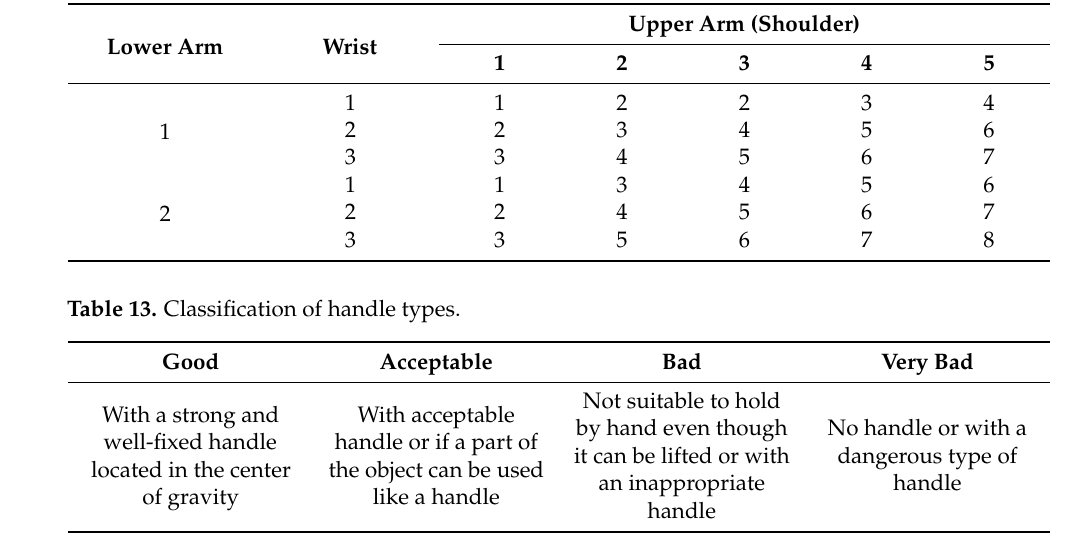
Table 12. Scoreboard for REBA Table B (upper arm(shoulder), lower arm, wrist).